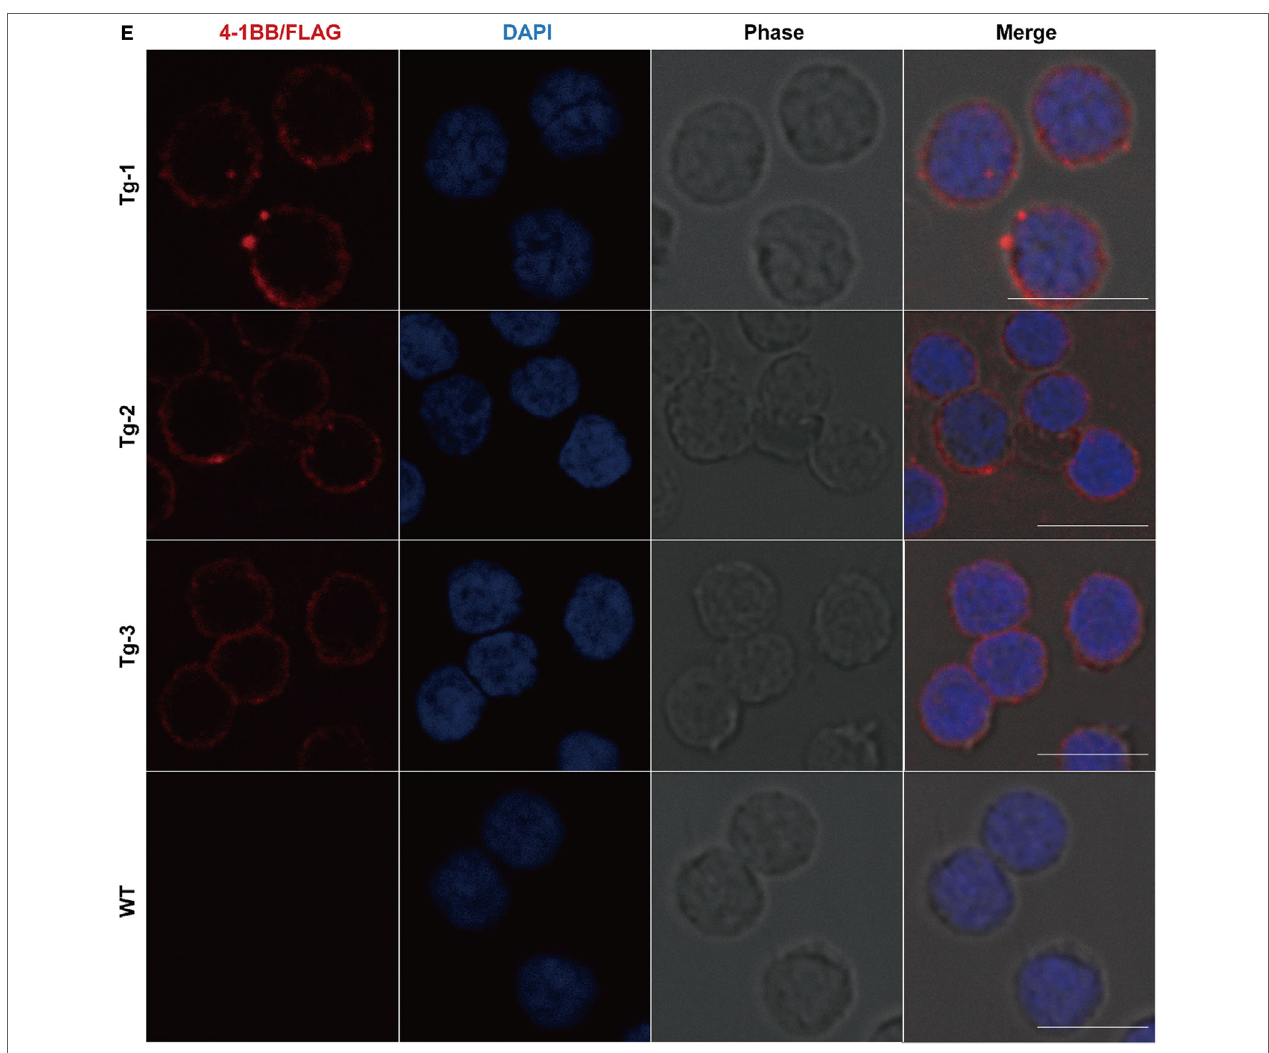
FigUre 3 | Production and identification of 4-1BB transgenic pigs. (a–D) PCR analysis of transgenic piglets using the indicated primers. 1–3, Genomic DNA from transgenic piglets; N, water; WT, wild-type pig. P in panel (a) indicates plasmid p4BOCNDR used as positive control. P in panel (D) indicates transgenic fibroblasts used as a positive control. (e) Representative immunofluorescent images of peripheral blood lymphocytes from transgenic pigs showing the expression of 4-1BB-FLAG on the cell membrane of lymphocytes. Scale bar, 10 µm. (F) Western blot analysis of peripheral blood lymphocytes from transgenic pigs. WT, peripheral blood lymphocytes from wild-type pig. (g) Southern blot analysis of transgenic pigs. WT, genomic DNA from wild-type pigs. (h) Real-time PCR analysis of the 4-1BB mRNA levels in transgenic (4-1BB Tg) and wild-type pigs (WT). P < 0.05 was considered statistically significant. (i) Images of F0 4-1BB transgenic